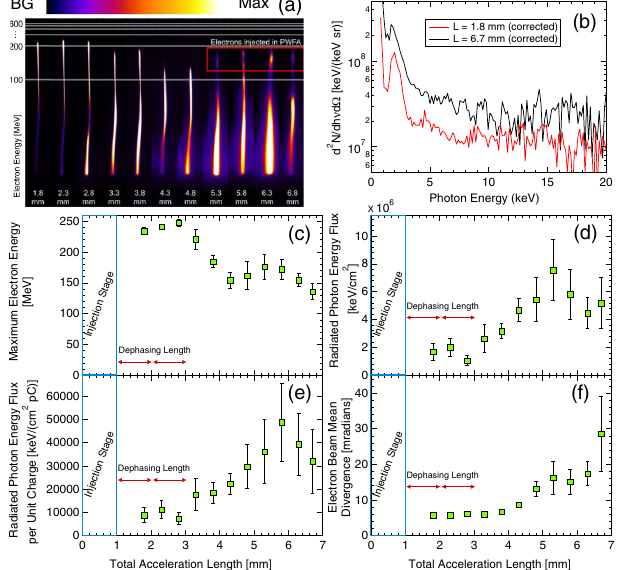
FIG. 2. (a) Typical electron p k − p ⊥ momentum distributions for various length gas cells measured using a magnetic spec- trometer. (b) X-ray spectra at two selected acceleration lengths with quantum efficiency and filter corrections applied. (c) Maxi- mum electron energy. (d) Total radiated photon energy (TRPE). (e) TRPE per unit charge. (f) Electron beam mean divergence. Parts (d) and (e) show a dramatic increase as a function of acceleration length at fixed density. Error bars denote the standard error of the